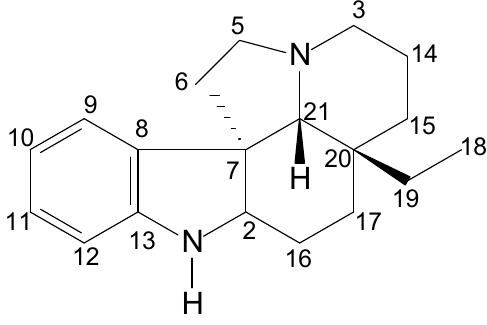
Figure 2. Numbering of the structure proposed by Le Men and Taylor